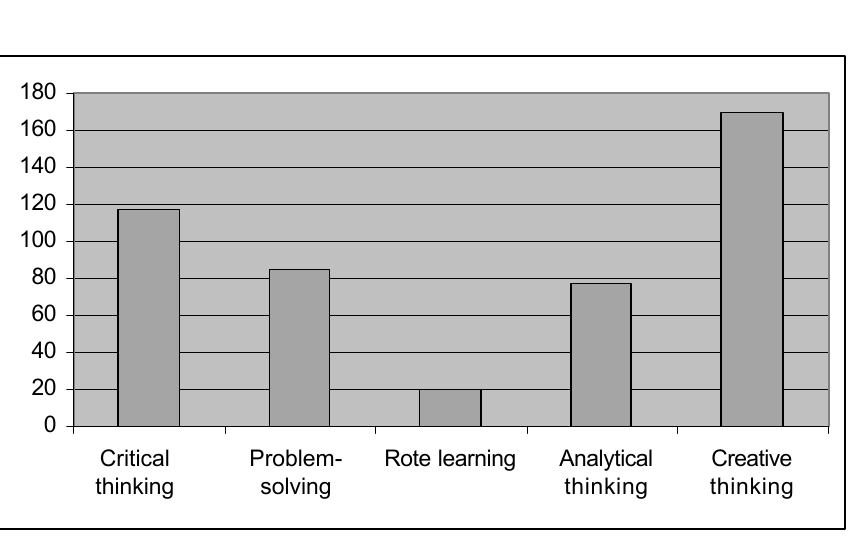
Figure 2. What kind of skills are technologies most useful for